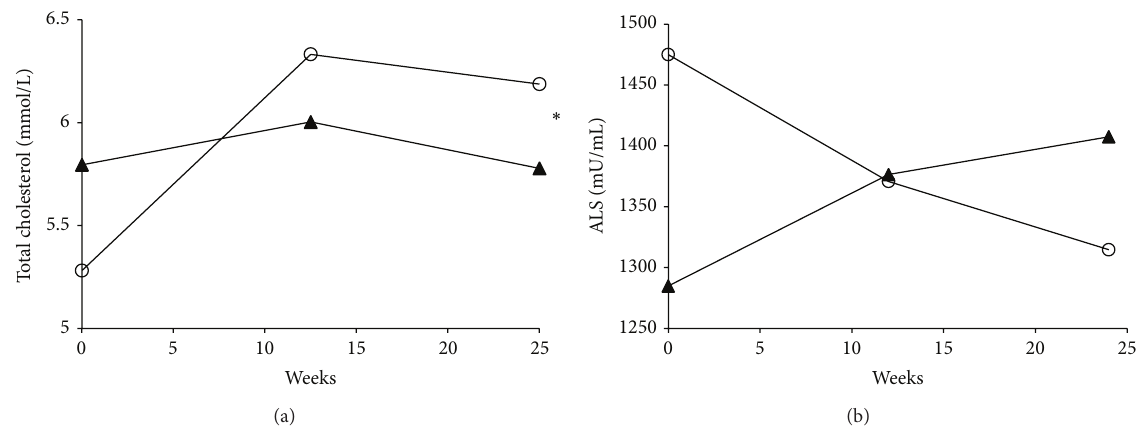
= 0.0302 for trend